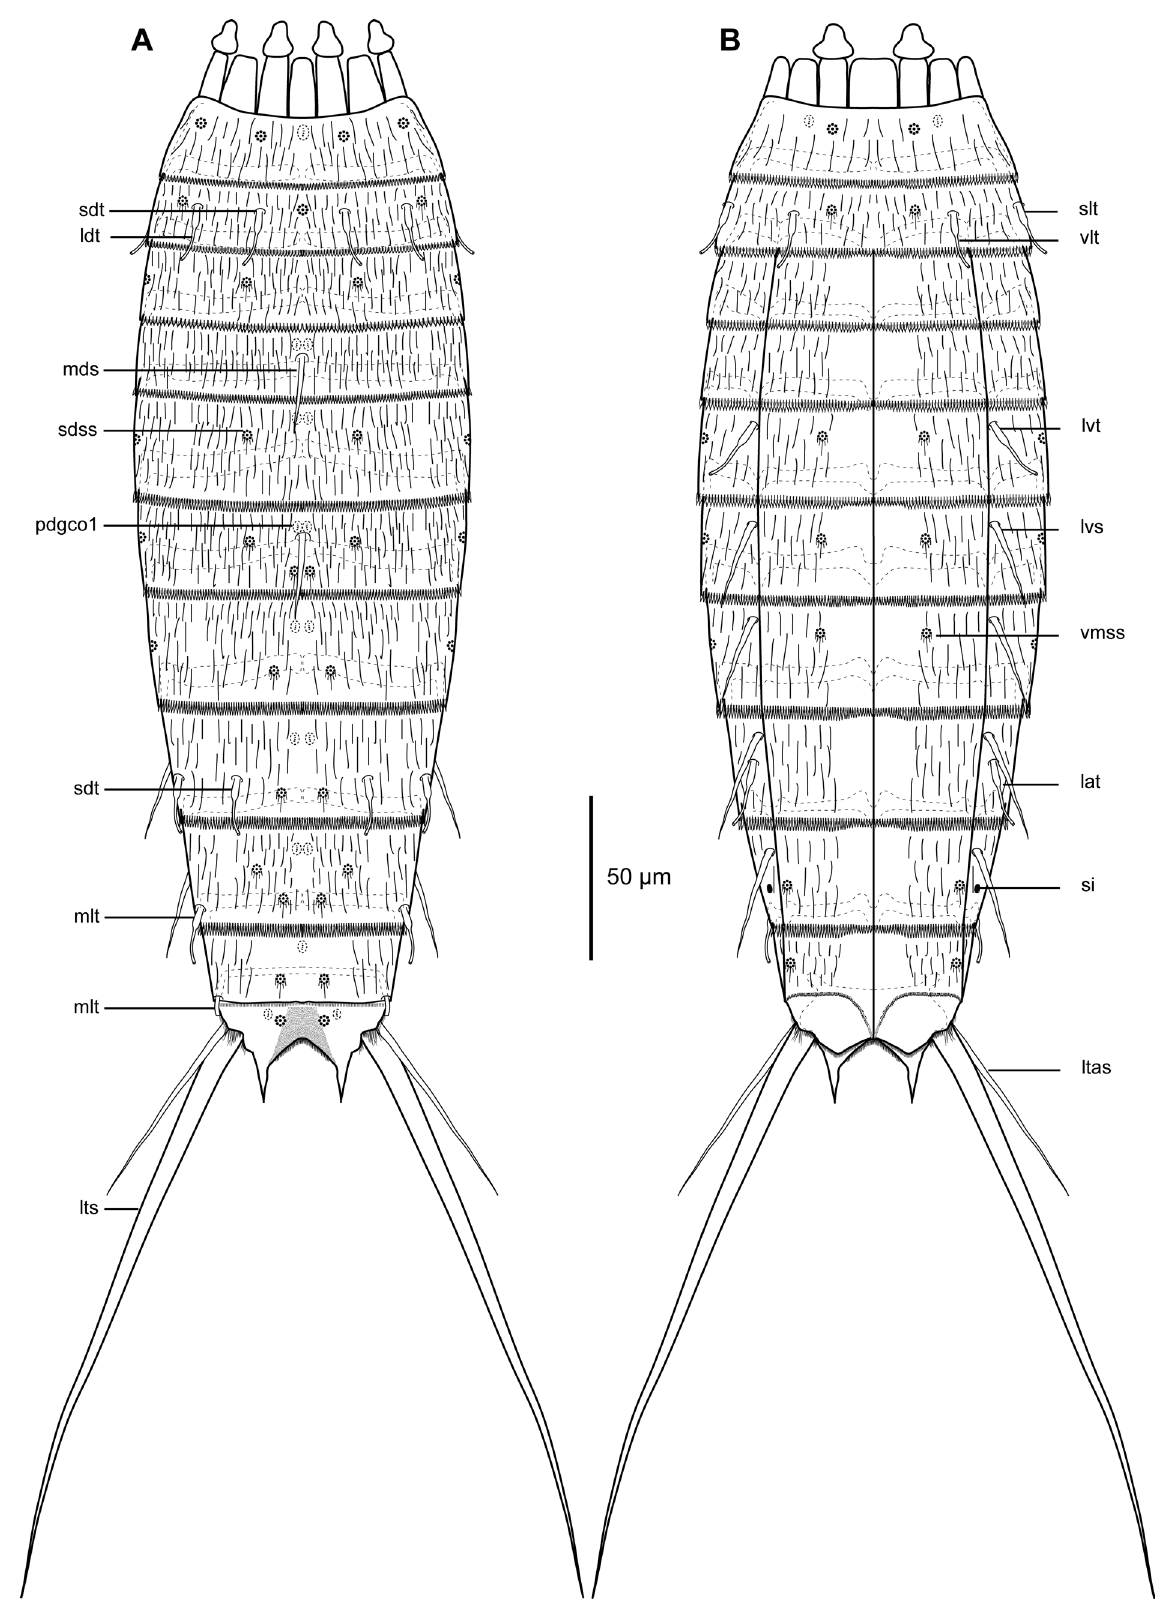
Fig. 5. Line art illustrations of Echinoderes landersi sp. nov. A . ♀, dorsal view. B . ♀, ventral view. Abbreviations: see Material and